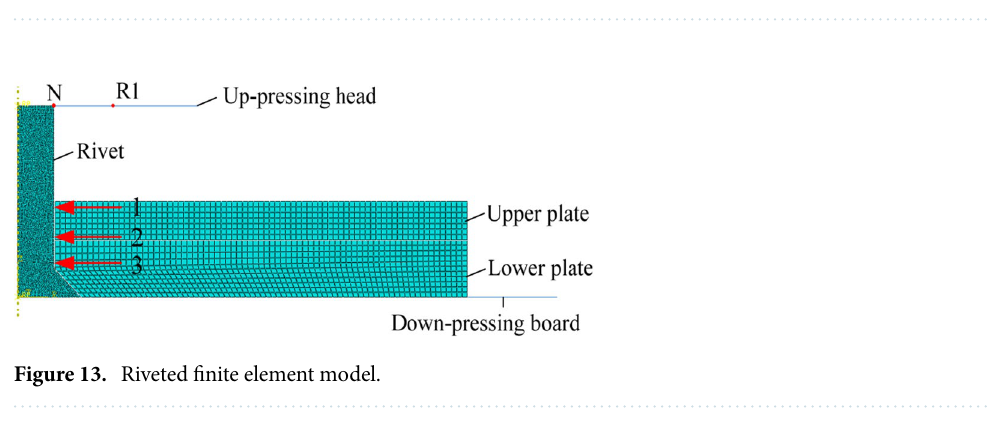
Table 4. Standard deviation coefficients of interferometry under different amplitude conditions.